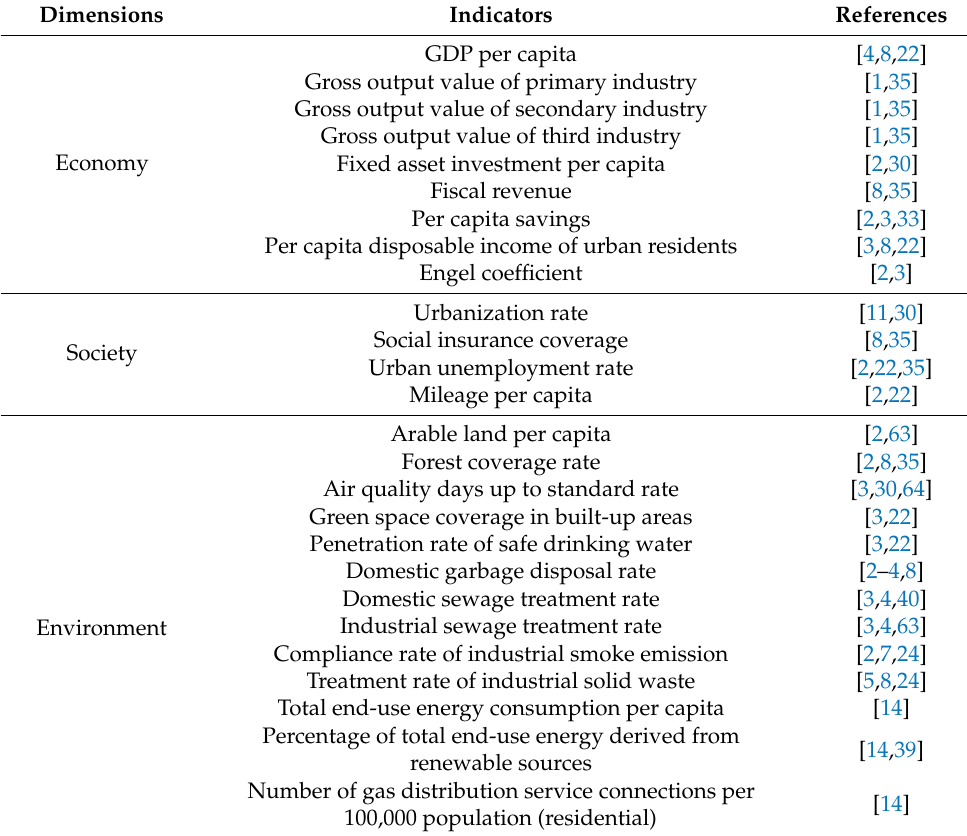
Table 5. Assessing indicators for sustainable contribution of infrastructure in